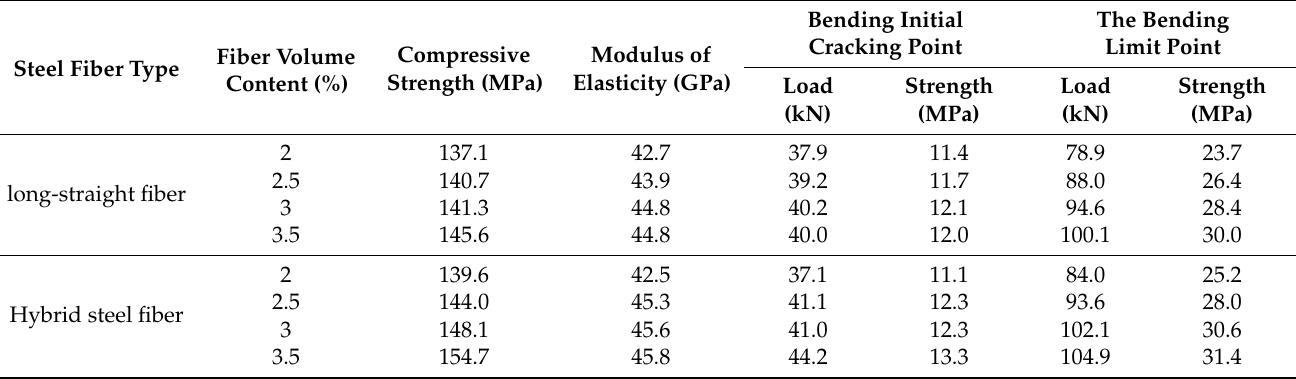
Table 3. The test results of material